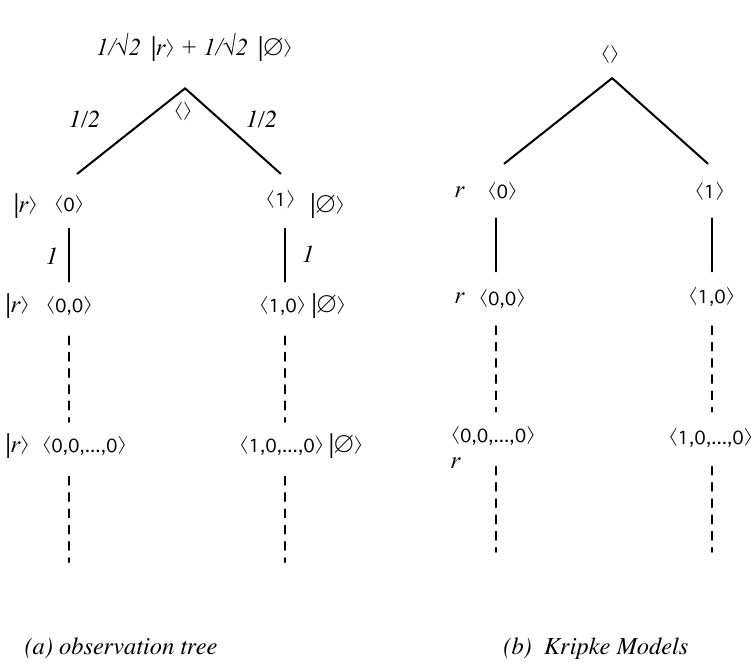
Figure 1. Tertium non datur: a